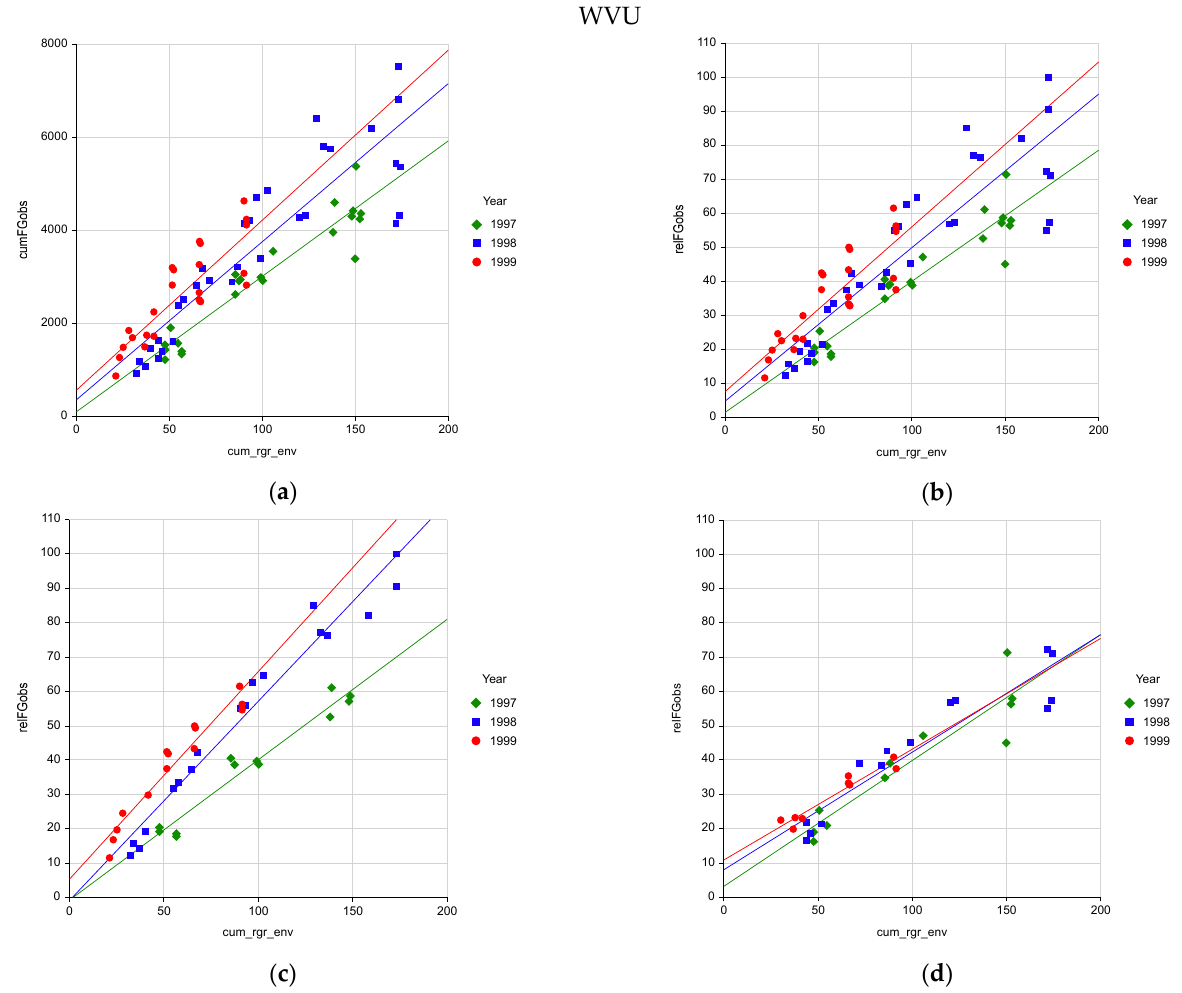
Figure 2. ( a ) Accuracy of the pasture growth model’s cumulative relative growth rate due to environment (cum_rgr_env) describing cumulative forage growth observed (cumFGobs) and ( b ) cumulative relative forage growth observed (relFGobs) at the WVU location over three years with ( c ) poultry litter treatments and ( d ) no-litter treatments showing the effect of cumulative nitrogen from poultry litter increasing pasture growth over time. Table 1. Accuracy of the pasture growth model’s cumulative relative growth rate due to the environment (cum_rgr_env) for describing cumulative forage growth observed (cumFGobs, kg/ha) and relative forage growth observed (relFGobs † ) at two sites over multiple years.